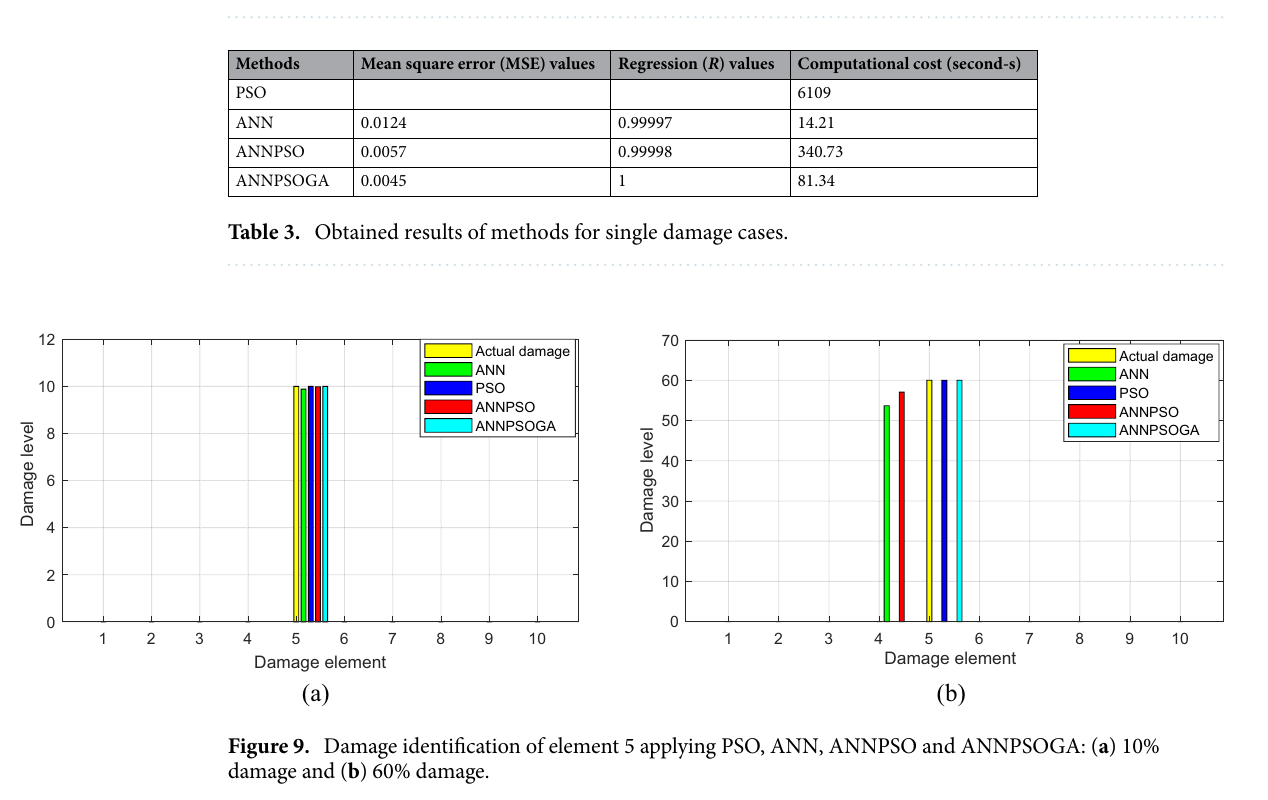
Figure 8. MSE-values: ( a ) ANN; ( b ) ANNPSO; ( c ) ANNPSOGA.